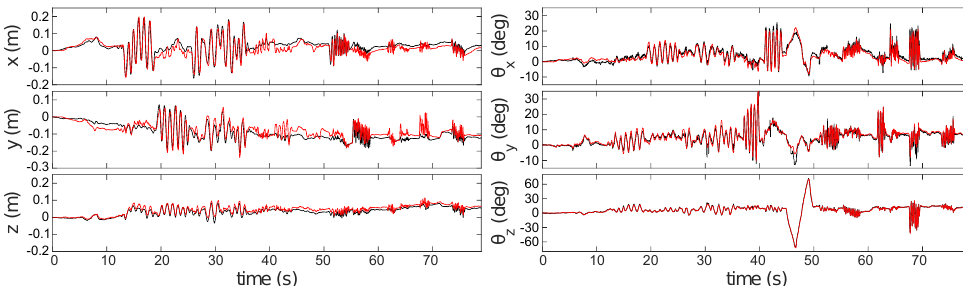
Figure 6. Comparison between pose estimates generated by ESPEE (red) and ground truth generated by the Vicon motion capture system (black). ESPEE is able to estimate the pose of the sensor.